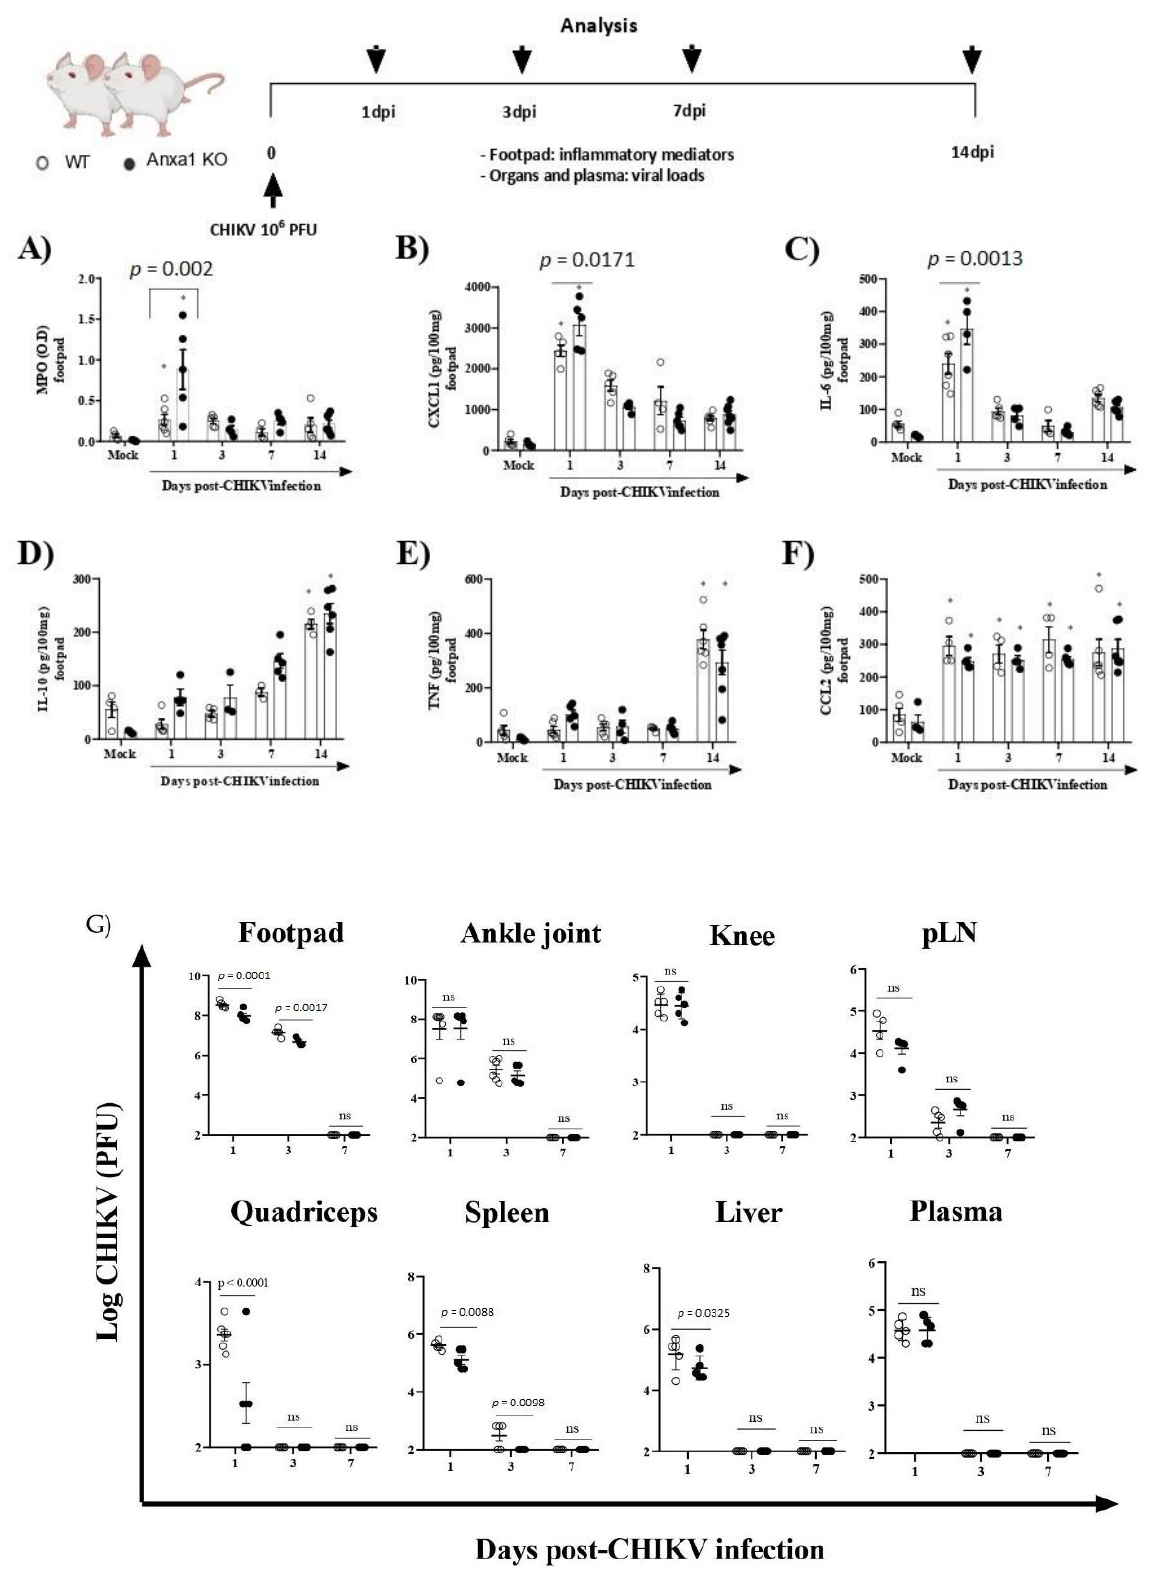
Figure 3. Absence of Annexin A1 ( AnxA1 ) increases inflammatory response induced by CHIKV. Annexin-A1 ( AnxA1 KO) or WT (BALB/c) mice were infected by the intraplantar (i.pl.) route with CHIKV 10 6 PFU and then were euthanized at 1, 3, 7 or 14 days post-infection. ( A ) MPO, ( B ) CXCL1, ( C ) IL-6, ( D ) IL-10, ( E ) TNF, and ( F ) CCL2 levels in the footpad of mice. The cytokines and